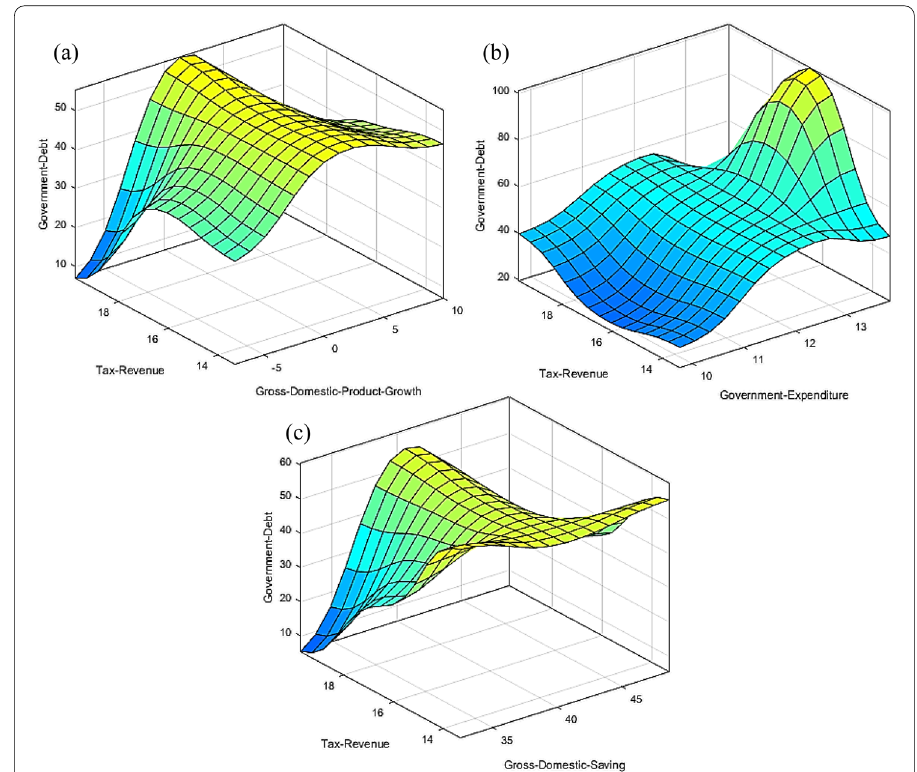
Fig. 5 Three-dimensional surface diagram of inputs and output parameters after ANFIS analysis. a The relationship between tax revenue and gross domestic product to the external debt; b the relationship between tax revenue and government expenditure to the external debt; c the relationship between tax revenue and gross domestic saving to the external